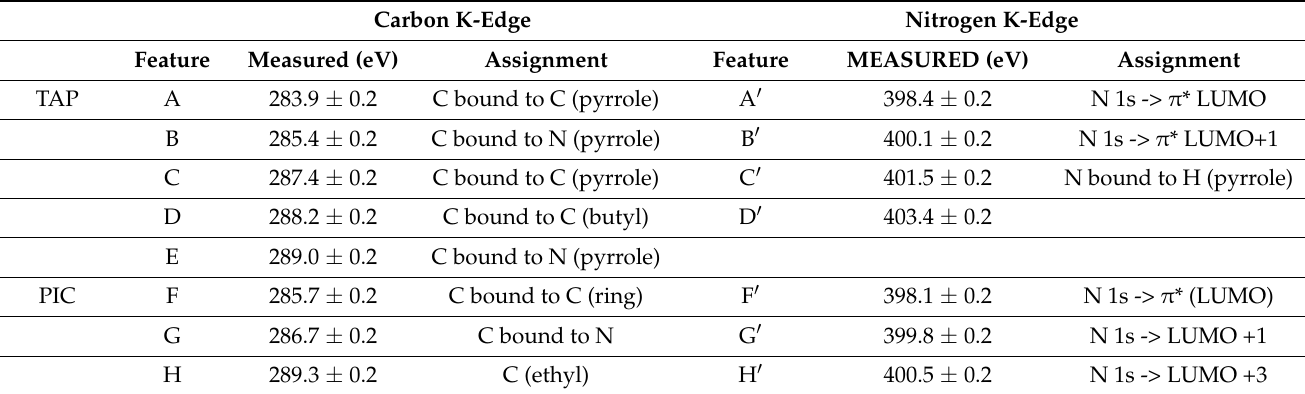
Table 1. Assignment of the measured peak positions for the carbon and nitrogen K-edge NEXAFS spectra of TAP and PIC. Carbon